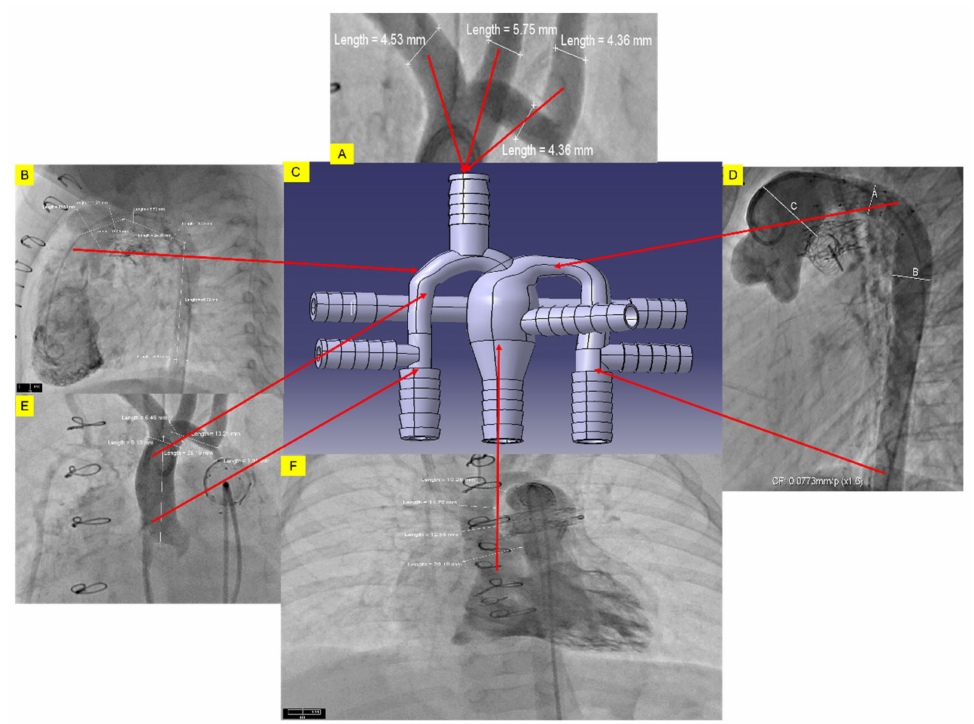
Figure 5. Development of a 3D CAD model of the HCSII centerpiece from deidentified angiographic images ( A ). Diameter of RCA, RSA, LCA, and LSA ( B ). Diameter of MPA root ( C ). Dimension of the 3D phantom with the labeled diameters (in mm) of labeled branches using CATIAv.5 ( D ). Diameters of the aortic arch and descending aorta ( E ). Diameter of AA ( F ). Diameter of